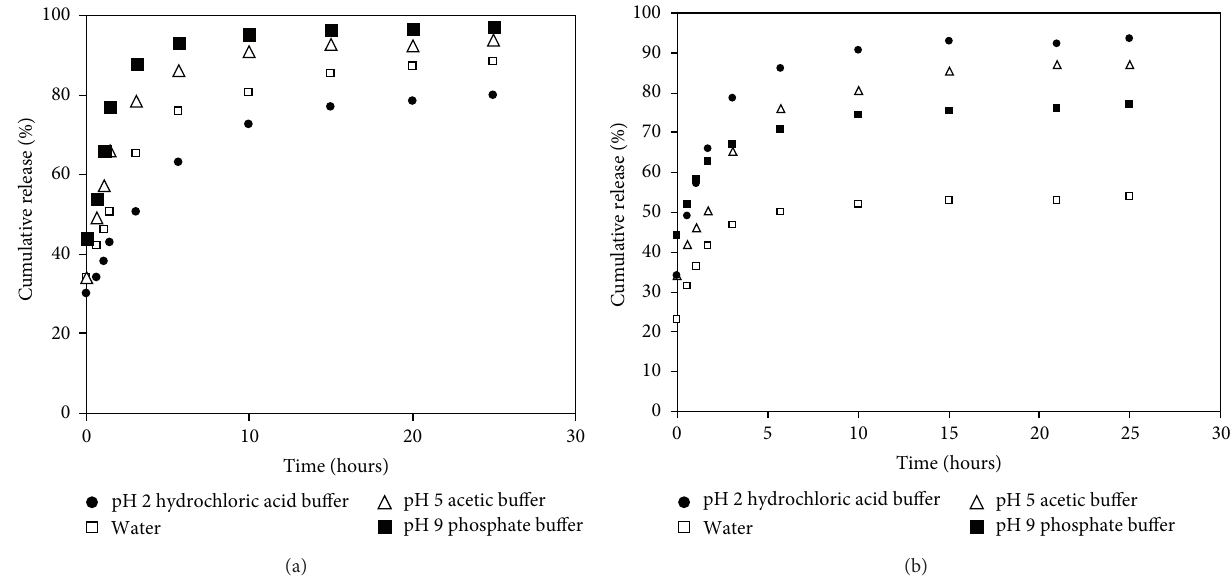
F 7: Pro�les of cumulatives release of valproic acid from (a) non-modi�ed SBA-15-VA sample and (b) APTES-modi�ed SBA-15- AP(1:15)-VAP sample.